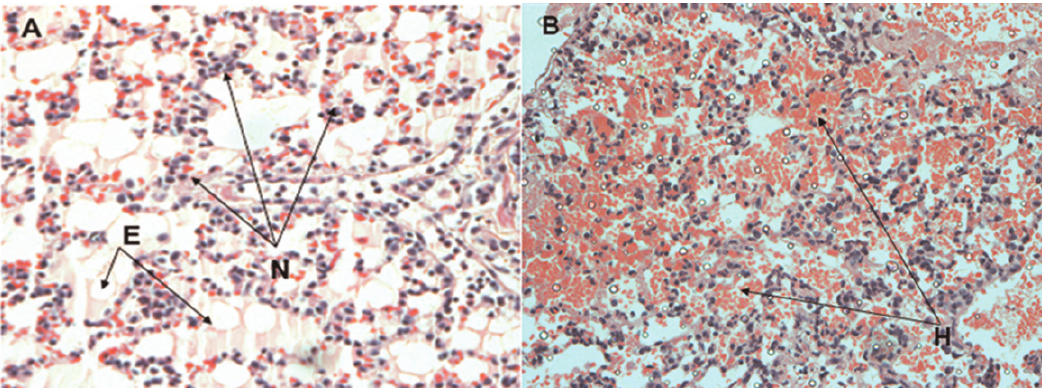
Figure 3 - The main histological findings in the control and methylprednisolone groups after lung transplantation. The lungs from the methylprednisolone group (A) showed the recruitment of septal neutrophils (N) and edema (E). The lungs from the control group (B) showed areas of hemorrhage (H) (200